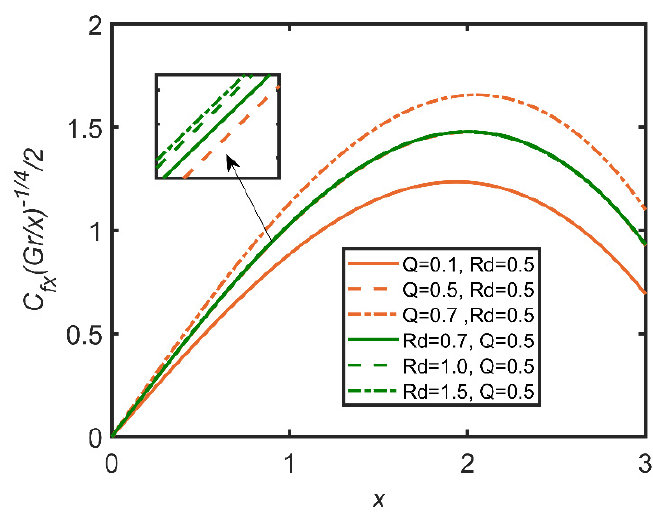
Figure 15. Comparison for skin friction against x.